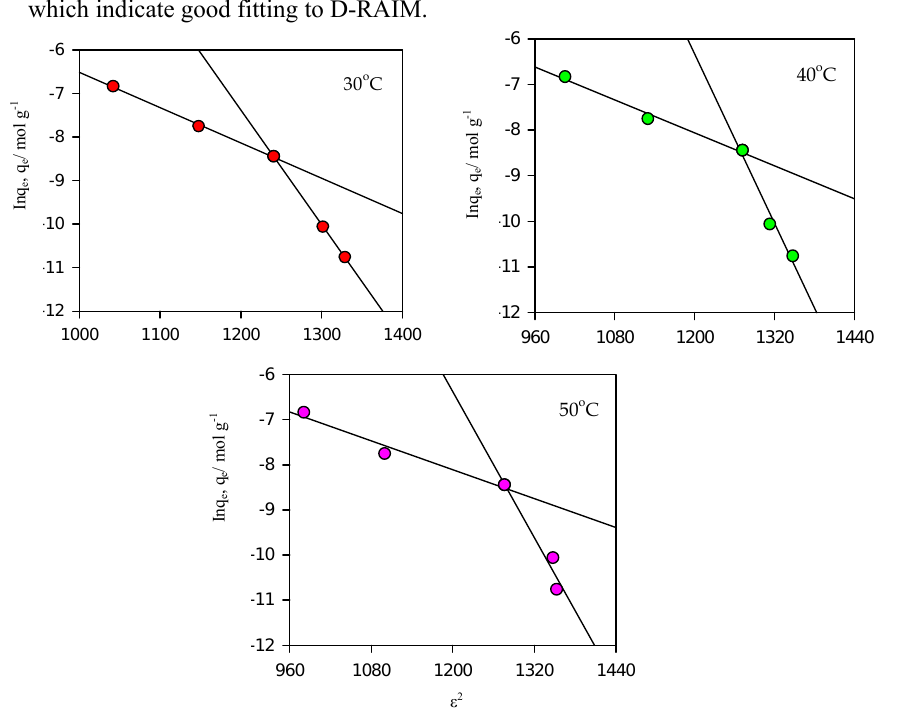
Figure 8. D-RAIM for the adsorption of 3-OCH different